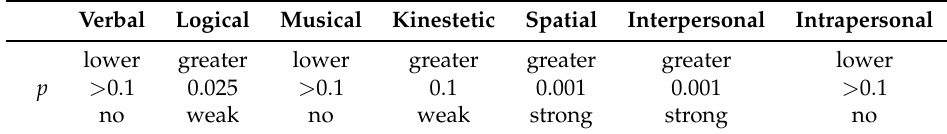
Table 2. Significant differences between raw score dimensions of the class and control group